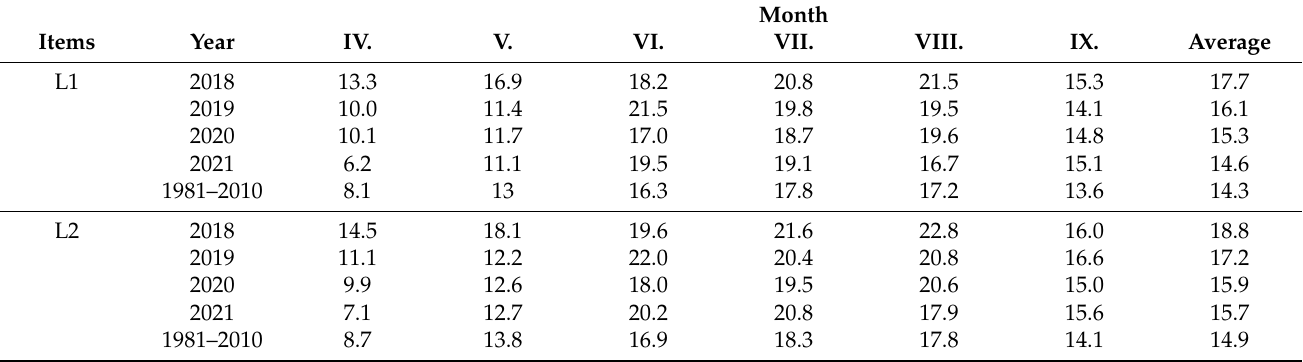
Table 2. Average temperatures ( ◦ C) in the growing season 2018–2021 (source: CHMI 2021).